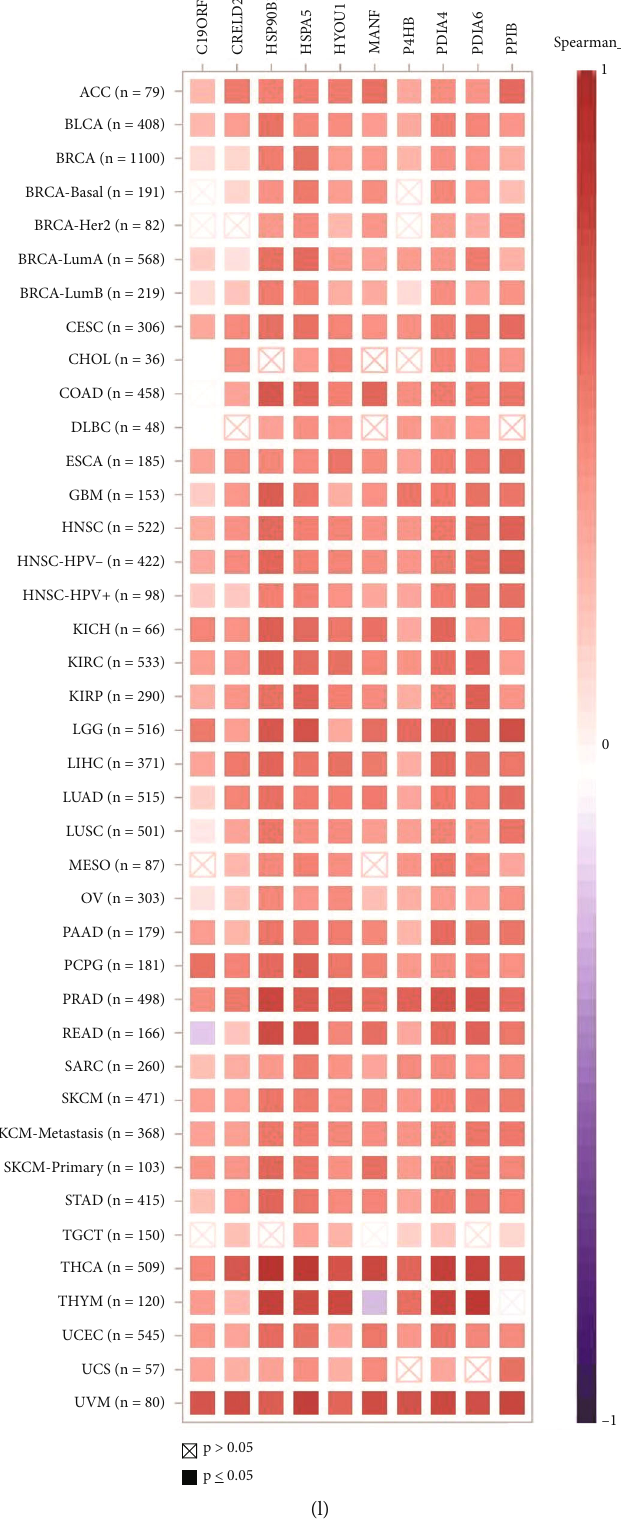
Figure 8: (a) Construction of PPI protein interaction network of PDIA3 gene. (b) – (k) Correlation between related genes and PDIA3 expression [(b): PPIB. (c): HSP90B1. (d): P4HB. (e): PDIA4. (f): HYOU1. (g): PDIA6. (h): MANF. (i): CRELD2. (j): HSPA5. (k): MYDGF (C19ORF10)]. (l) The expression of 10 target genes in each